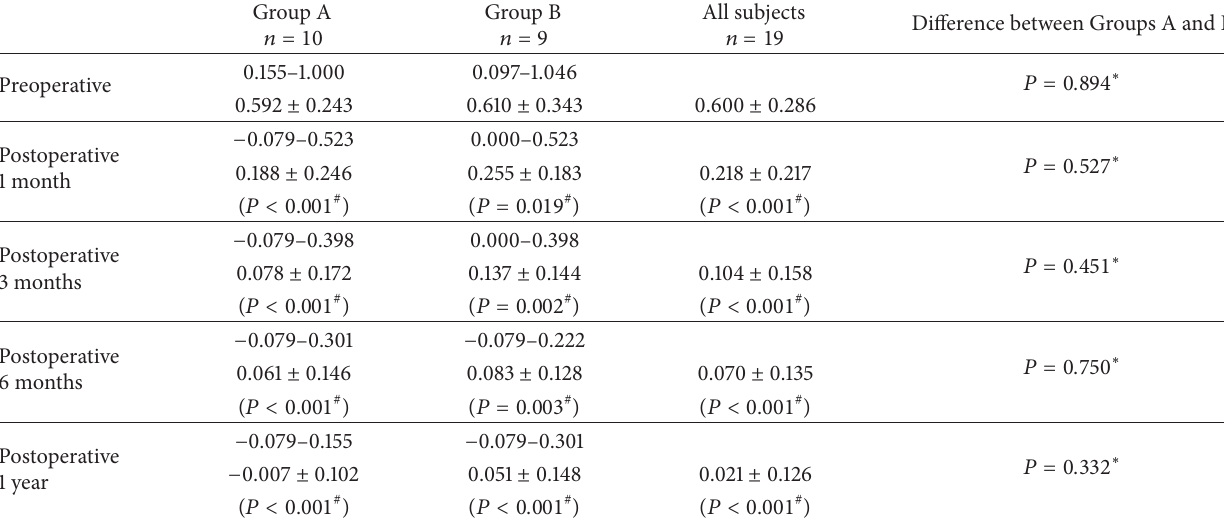
Table 3: Preoperative and postoperative logMAR VA.